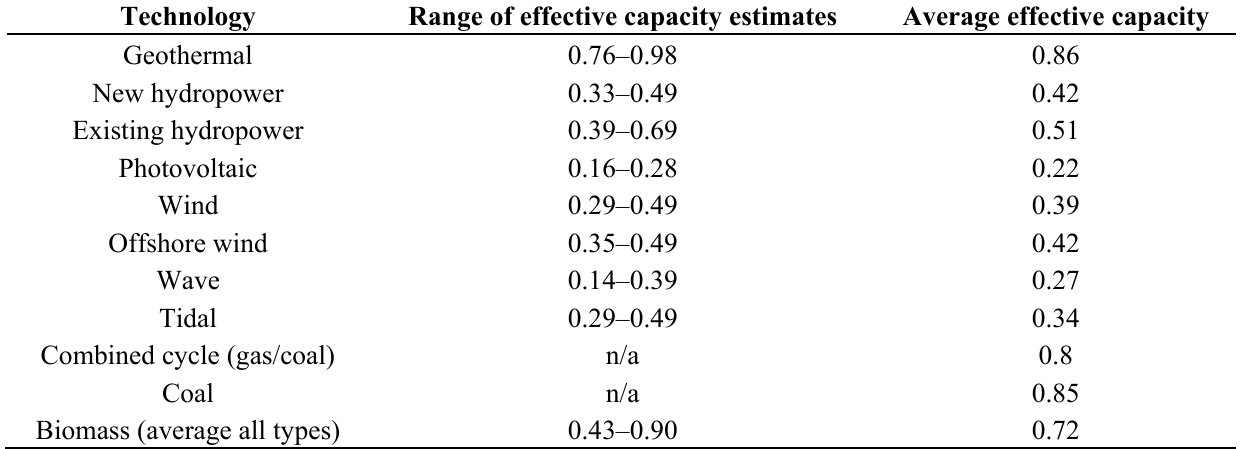
Table 3. Effective capacity estimates for the